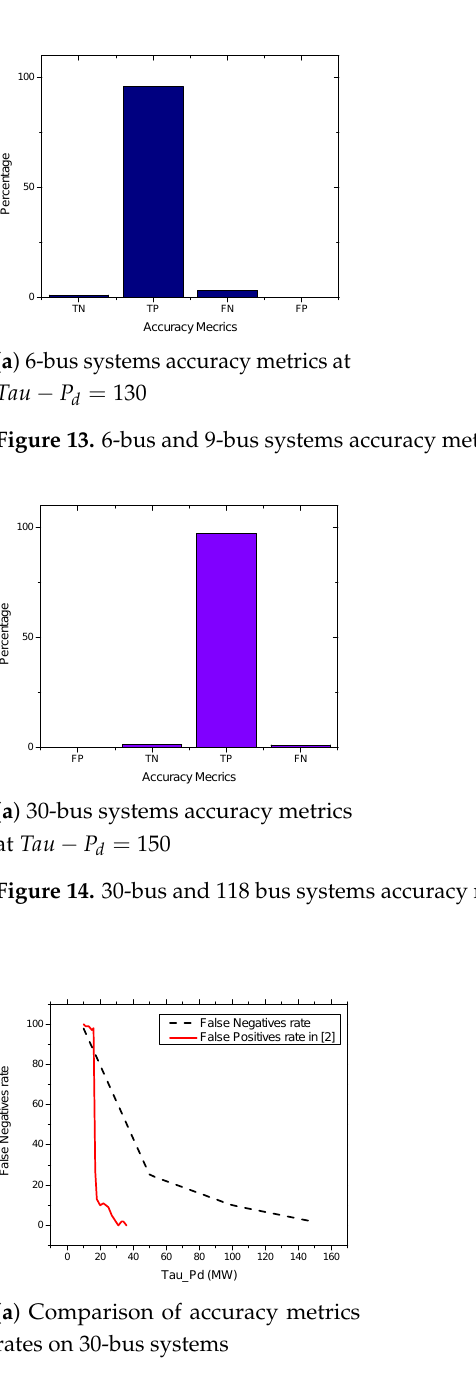
Figure 15. Comparison of accuracy metrics rates on 30 and 118-bus